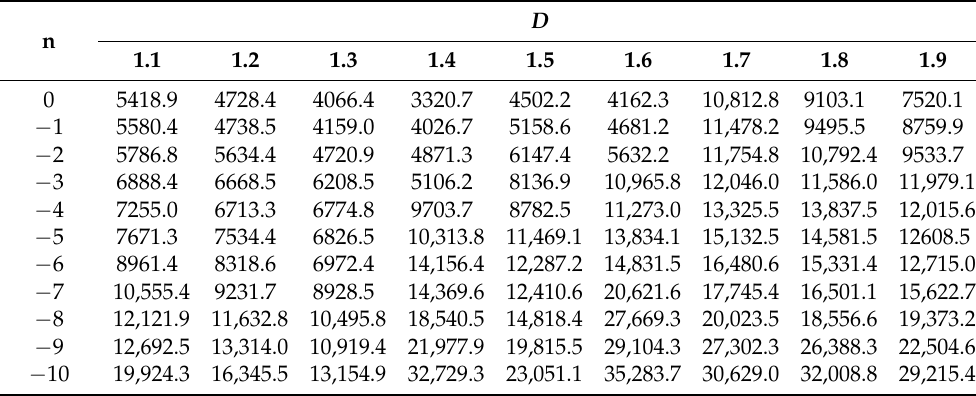
Table A7. L c of corner points under all initial values of n and all fractal dimensions.